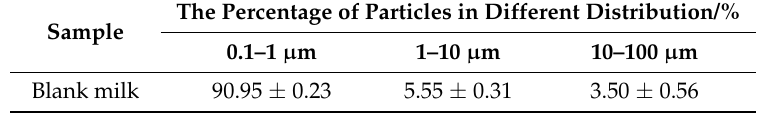
Table 2. The particle size distribution of blank milk system.